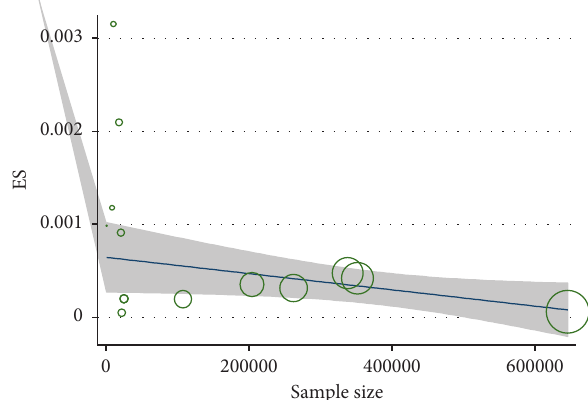
Figure 4: Relationship between the incidence of infectious keratitis and the number of research samples after keratorefractive